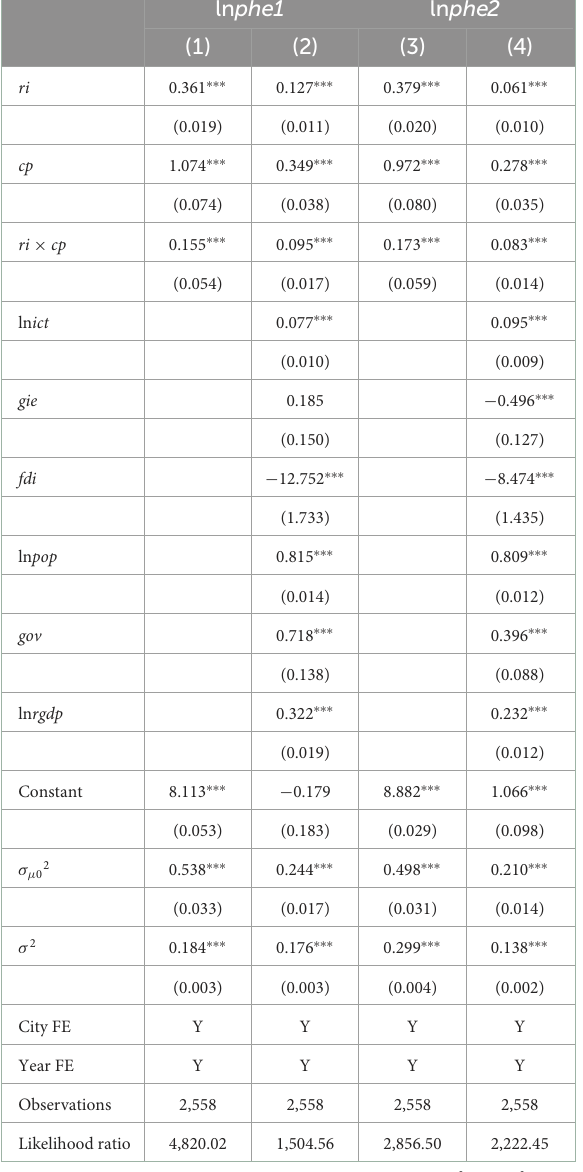
TABLE 4 Impact of regional integration on public healthcare environment in core cities and peripheral